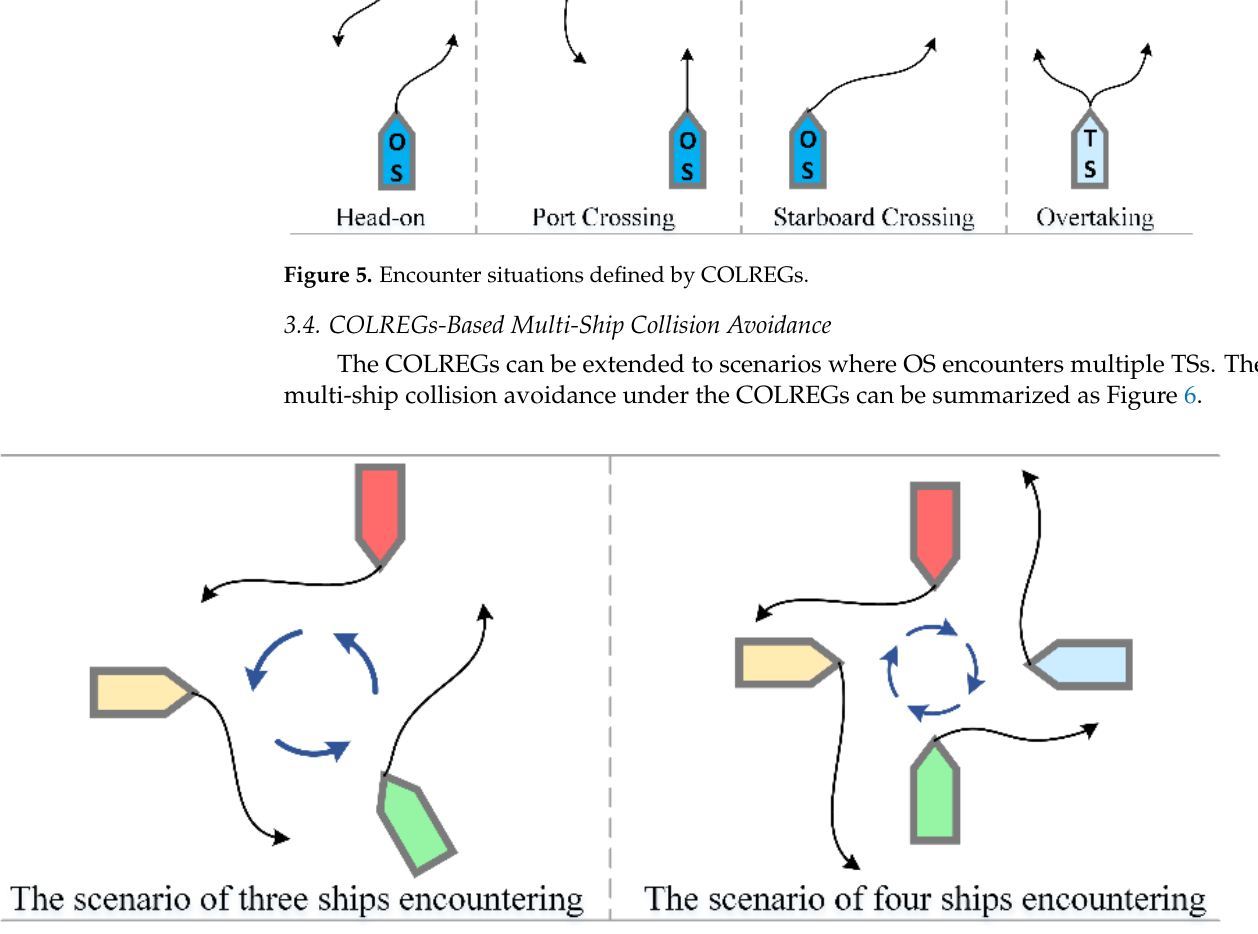
Figure 5. Encounter situations defined by COLREGs.